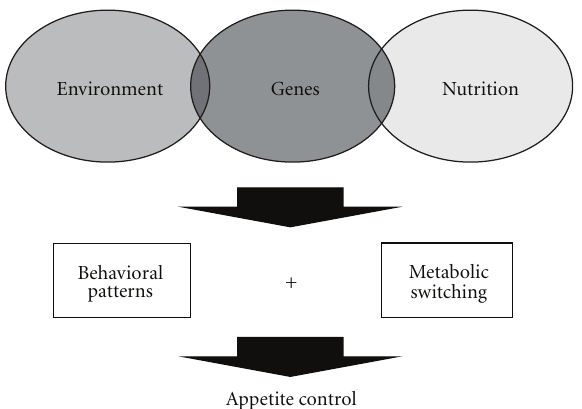
Figure 2: Appetite control is a very complex network, which has to intertwine genetic factors, nutritional signals, and environmental determinants. The making of metabolic switches and acquiring food-seeking related behavioral patterns is the final combination to manage food